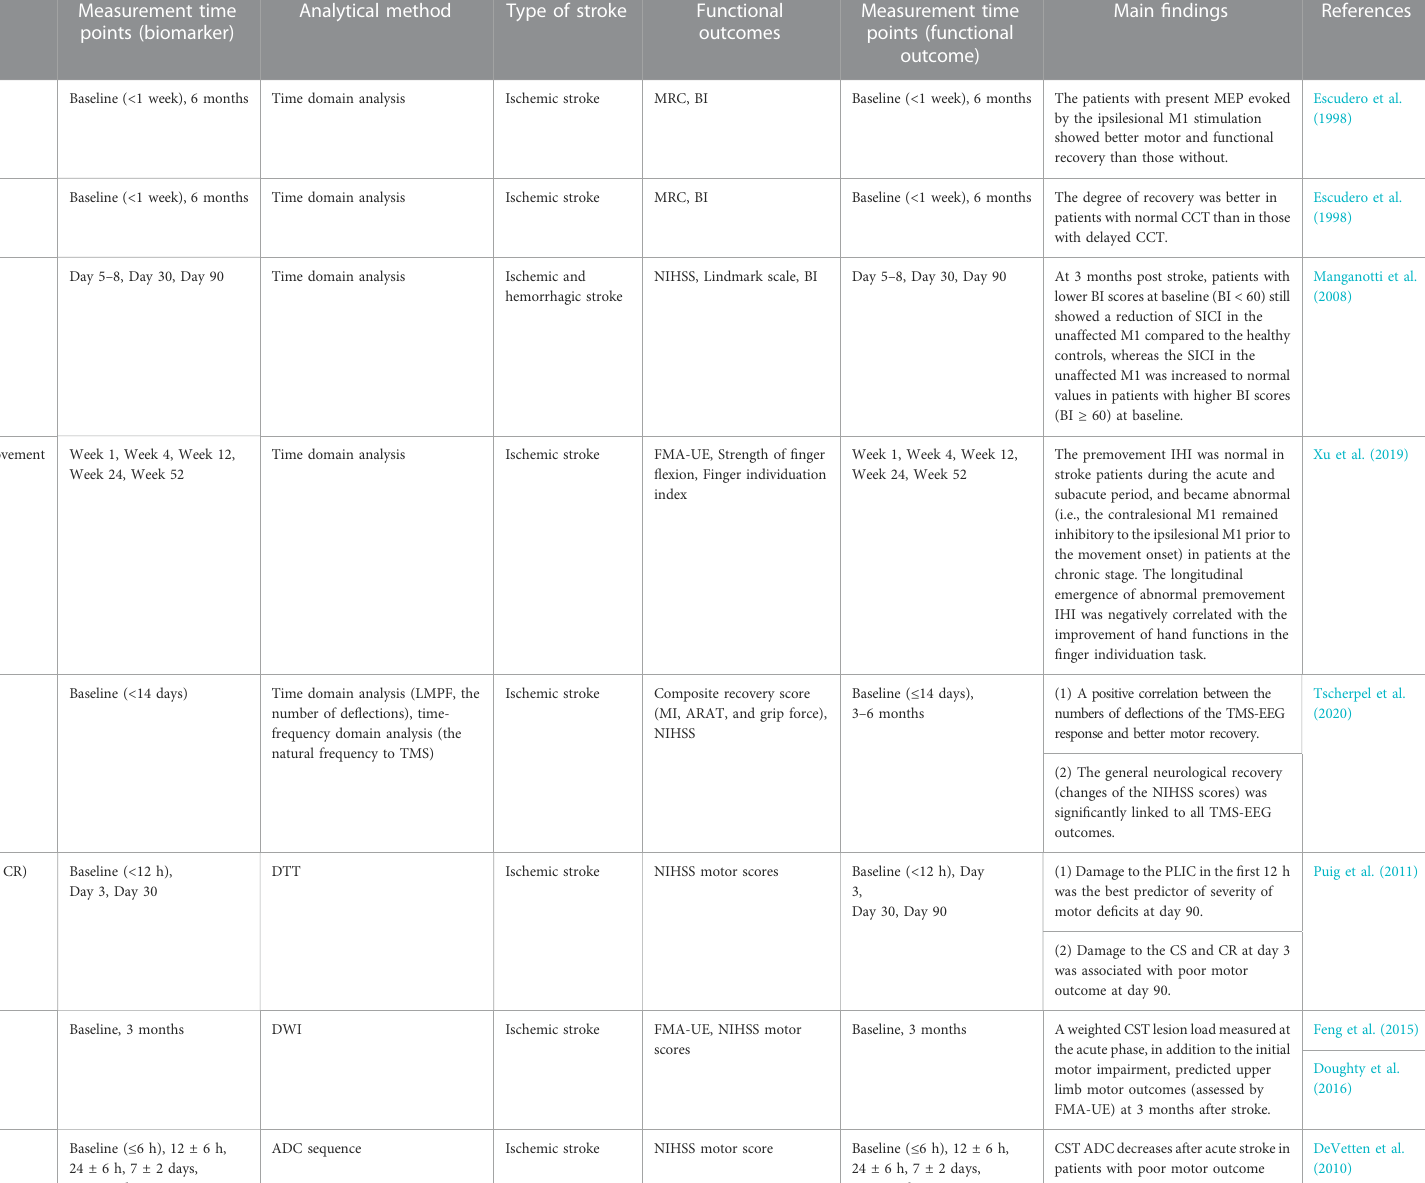
showed better motor and functional recovery than those without.